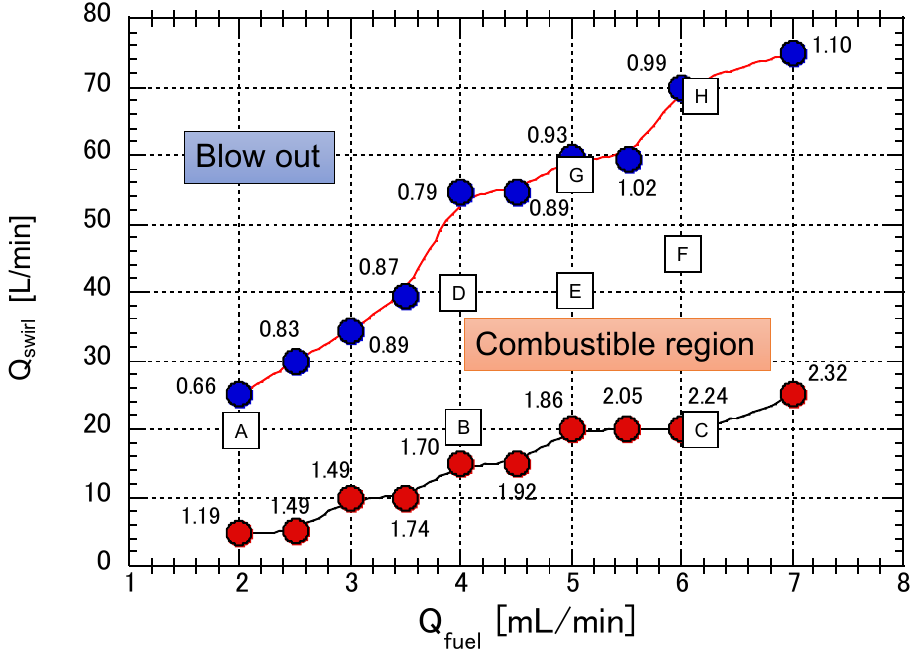
Figure 8. Flame morphology map.